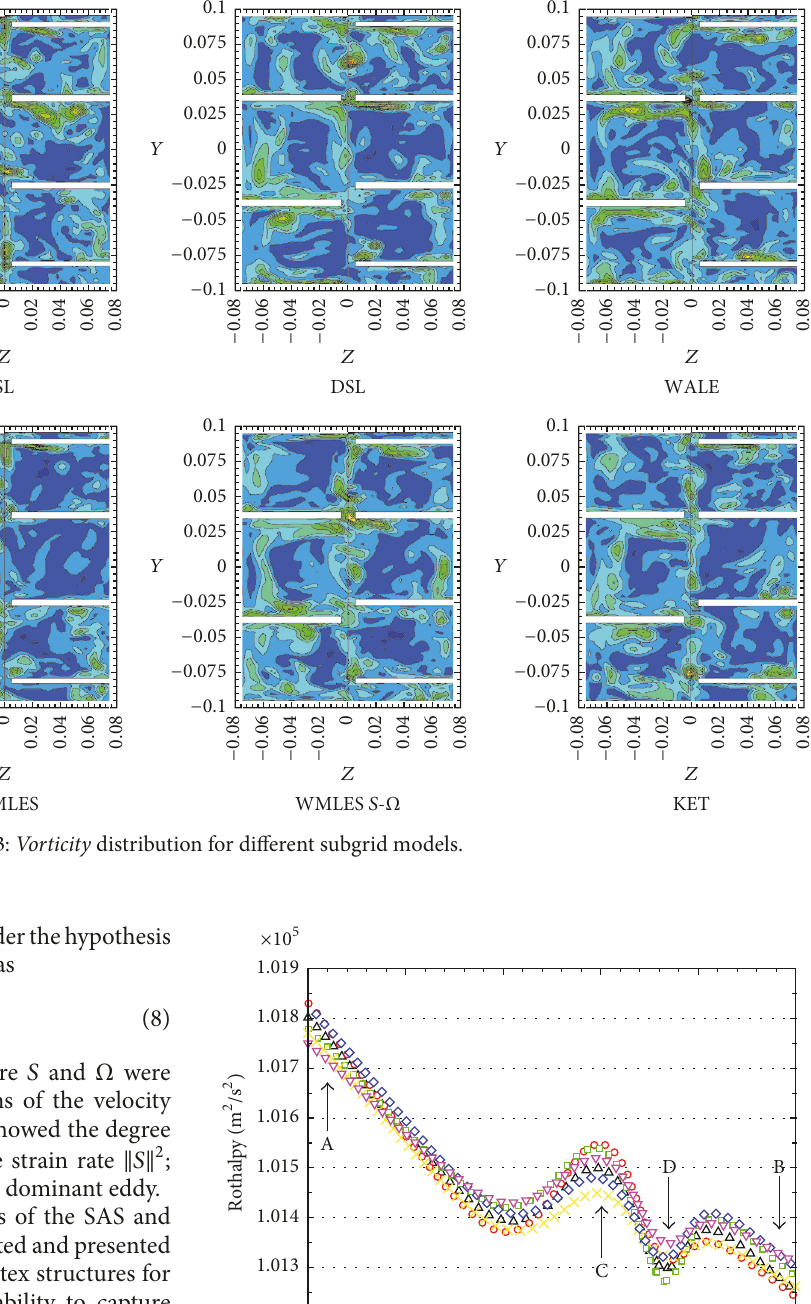
KET captured abundant vortex structures and provided a relatively moderate eddy